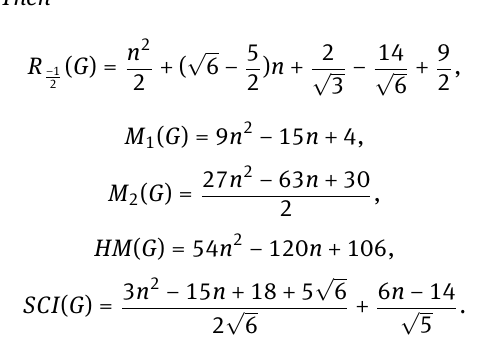
Figure 2: OTIS swapped network O P based on degrees of end vertices of each edge. Table O P n 1 shows such an edge partition for O and (3) in Table 1, we obtain the expression of the indices.